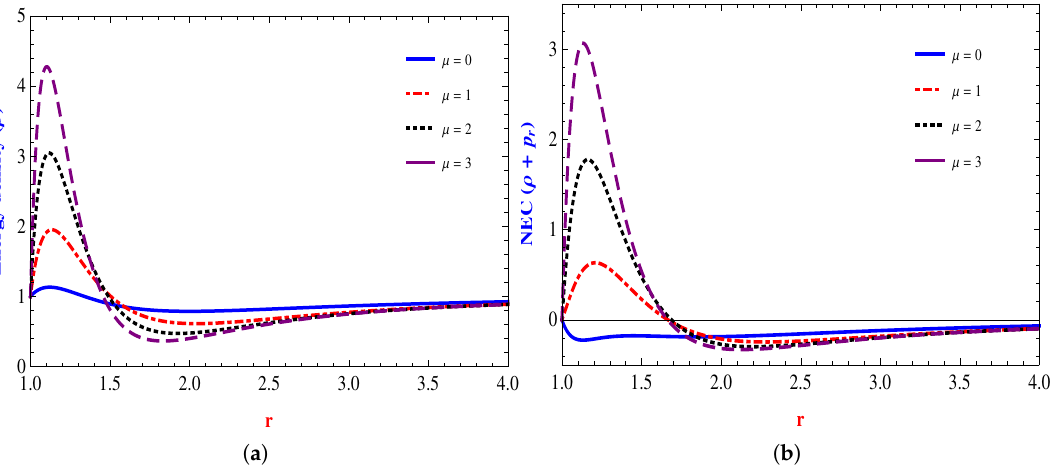
Figure 4. Plots: ( a ) Energy density ( ρ ) and ( b ) radial NEC ( ρ + p r ) with throat radius r 0 = 1, α = 1, and β = 2 in f ( Q ) = α Q 2 + β